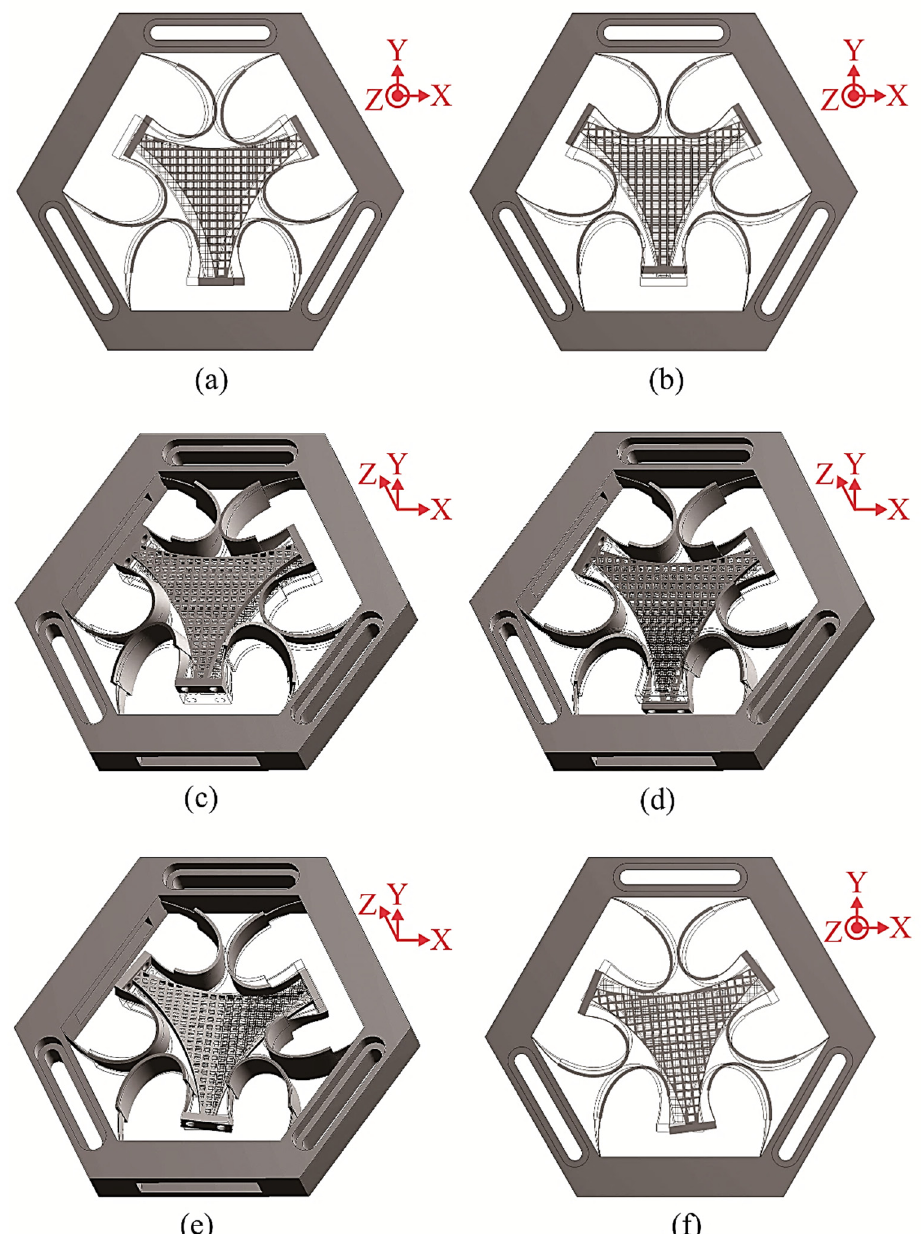
Figure 4. Illustration of six degrees-of-freedom (DOF) of the CPM: ( a – c ) Translations along the X, Y, and Z axes, respectively; ( d – f ) Rotations about the X, Y, and Z axes, respectively.